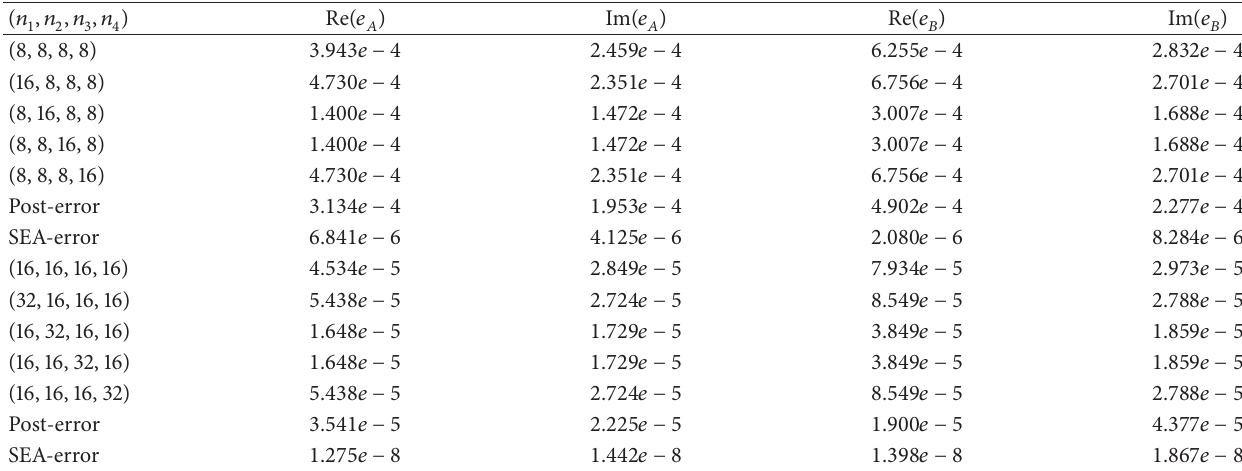
Table 1: The numerical results.